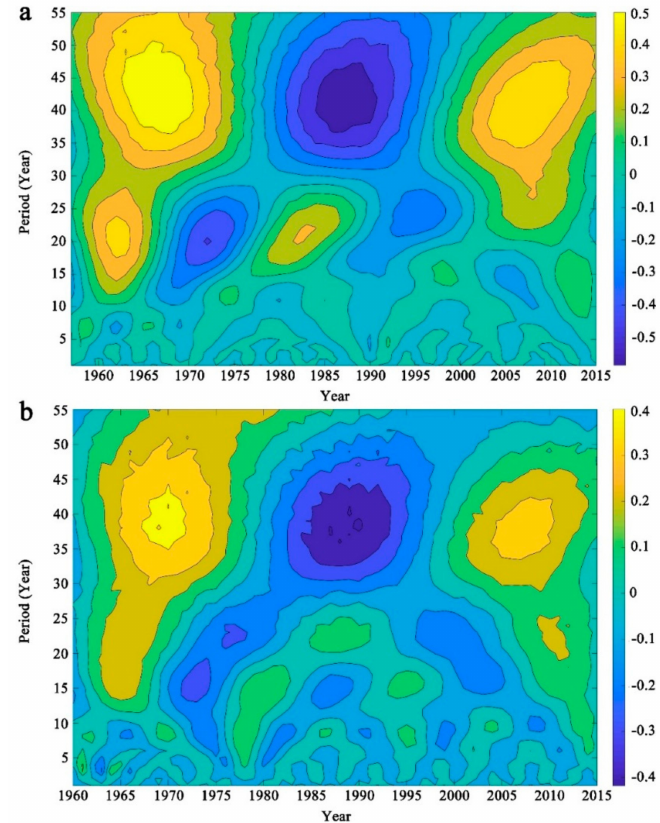
Figure 2. The baseflow real part map of wavelet coe ffi cients of two watersheds. ( a ). Hailiutuhe; ( b ).